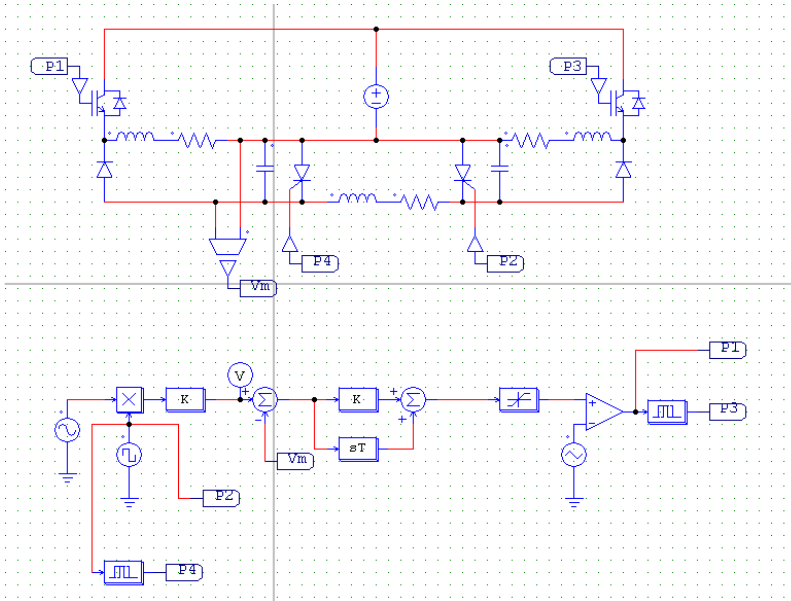
Figure 8. Simulated Single-Phase Buck–Boost Converter using PSIM Software.